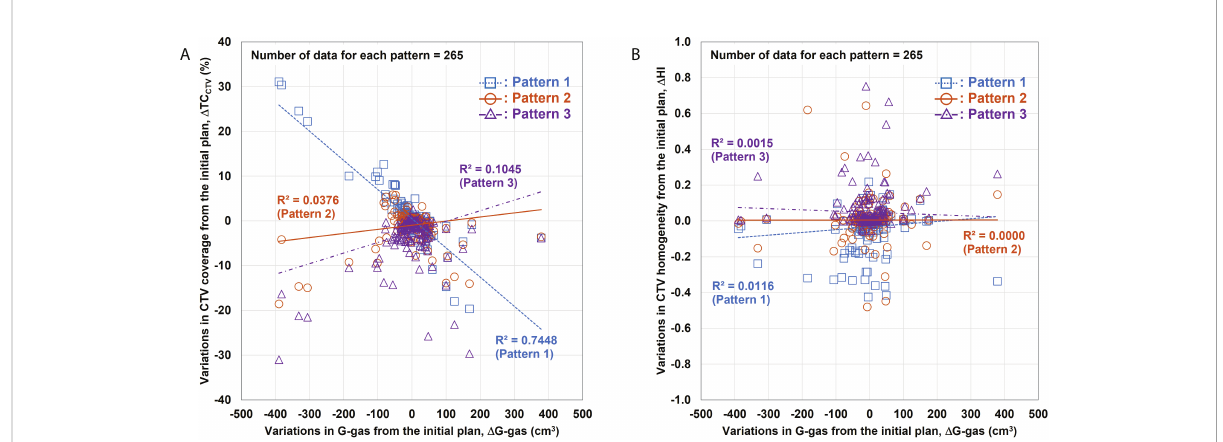
FIGURE 5 Relationship between variations in the gastrointestinal gas ( D G-gas) volume and the variations in the clinical target volume (CTV) coverage ( D TC CTV ) and homogeneity index ( D HI). (A) Relationship between D G-gas and D TC CTV (V95%); (B) D HI. The horizontal axis shows the volume variation in G-gas from the initial plan. The effect of the beam range is considered in D G-gas. The vertical axes in (A) and (B) show the variations in TC CTV and HI from the initial plan, respectively. The smaller the gradient, the smaller the effect of